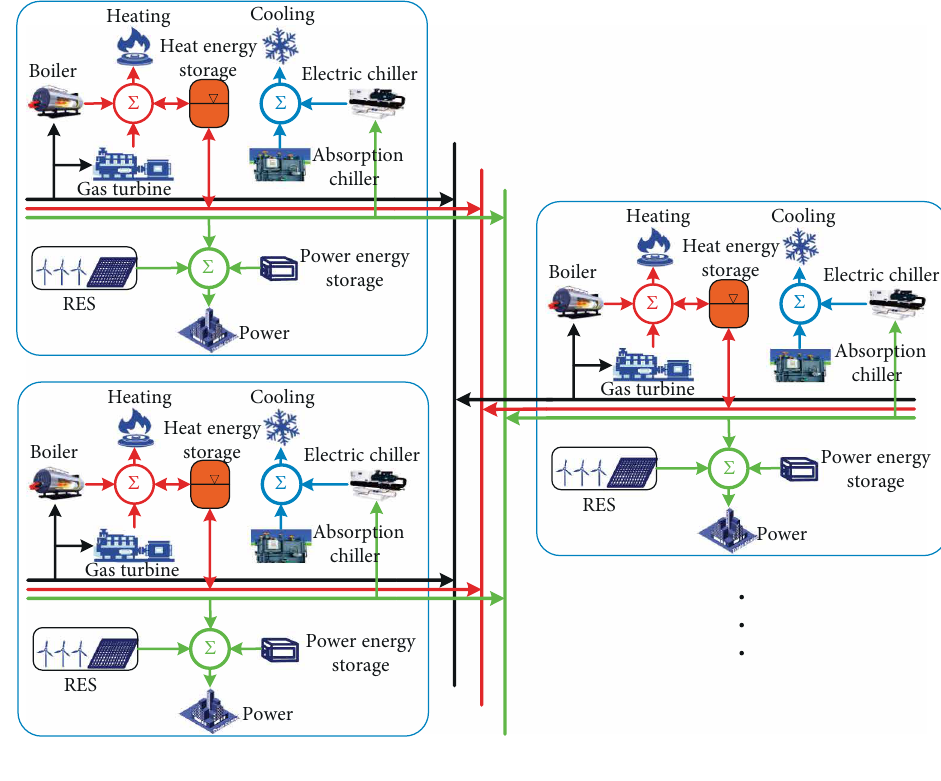
Figure 4: Schematic of cross-regional